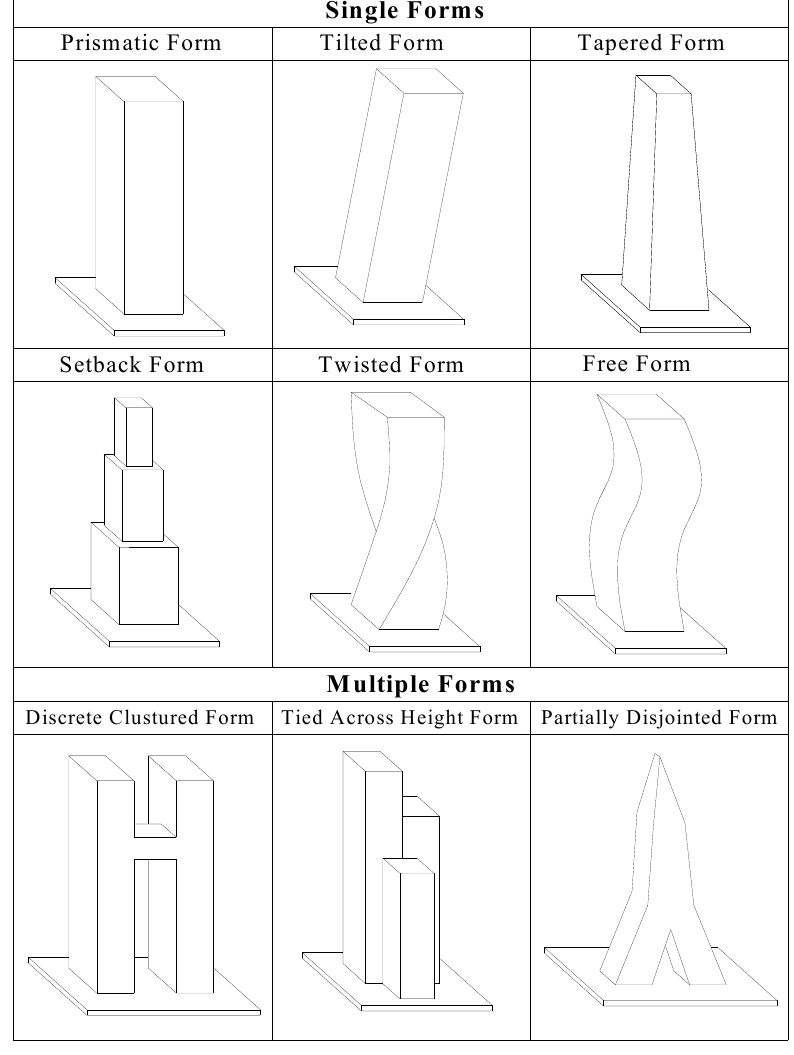
Figure 3. Tower form classification for tall buildings. Table 2. Classification of selected tall buildings by building form.